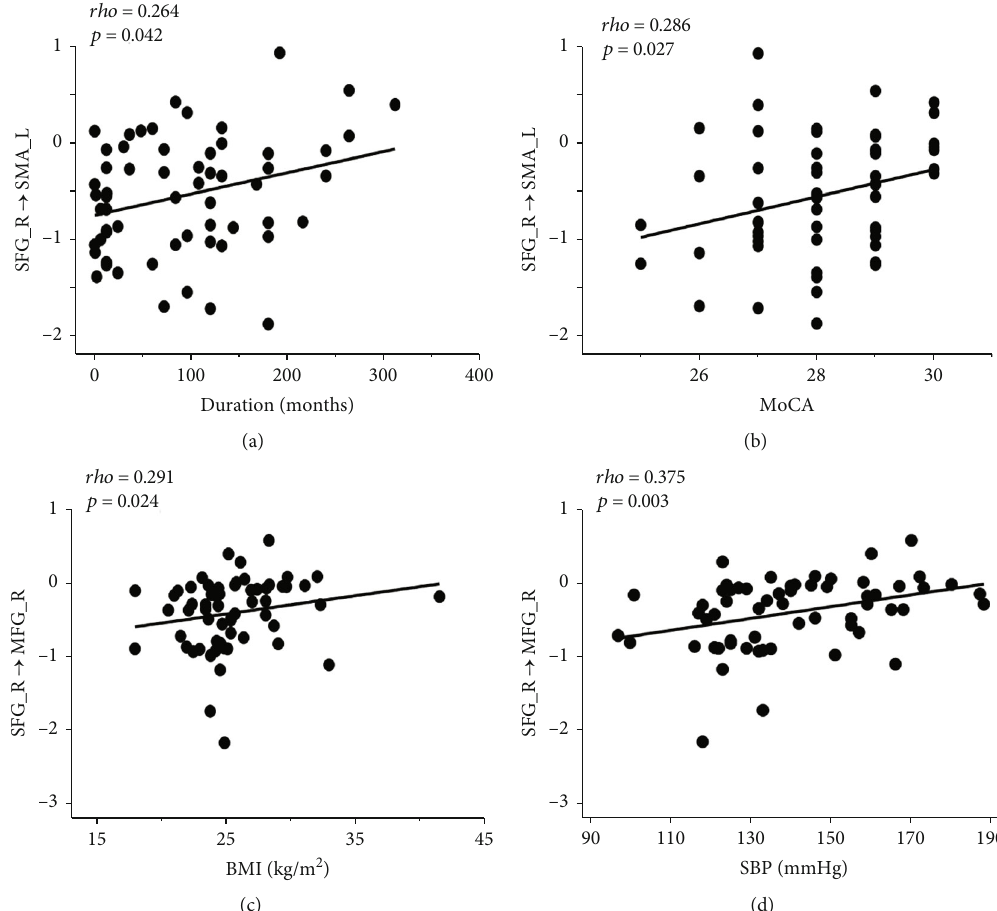
Figure 4: Signi fi cant correlations between abnormal e ff ective connectivity of right superior frontal gyrus and clinical characteristics in type 2 diabetes ( P < 0 : 05 ). MFG: medial frontal gyrus; MoCA: Montreal Cognitive Assessment; SBP: systolic blood pressure; SFG: superior frontal gyrus; SMA: supplementary motor